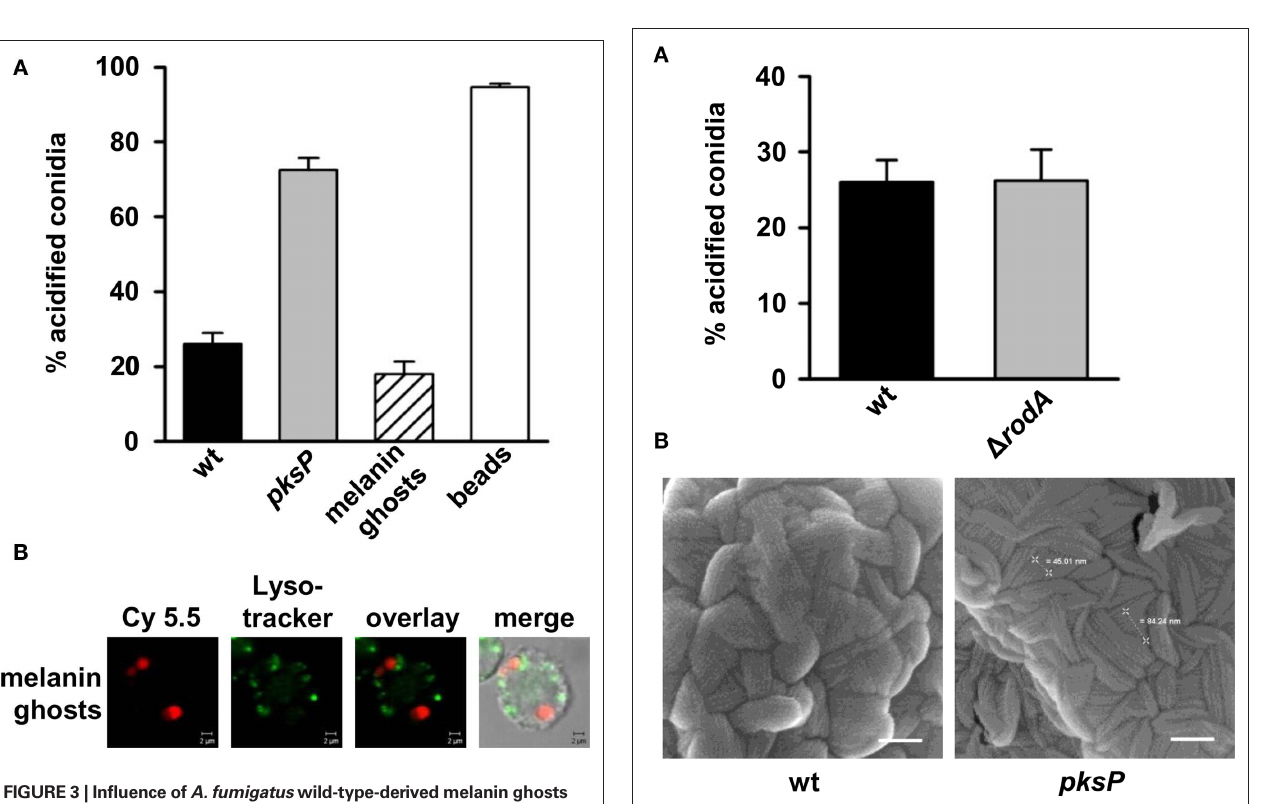
FiguRe 4 | Absence of conidial surface hydrophobin RodA does not alter phagolysosomal acidification. (A) Percentage of intracellular conidia residing in acidified phagolysosomes after phagocytosis by MH-S cells. Values represent the mean + SD of three experiments. (B) Scanning electron microscopy (SEM) micrographs of resting conidia. Resting conidia exhibit conidial surface hydrophobin layer (rodlet structure). Scale bars =